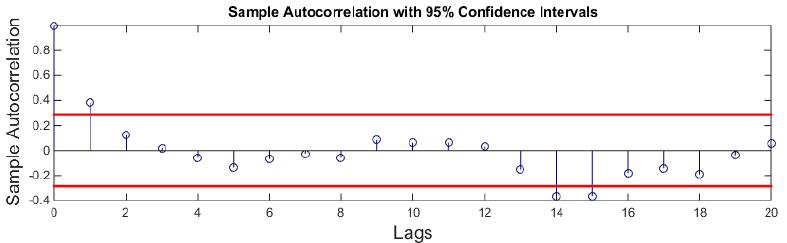
Figure 12. ACF plot.